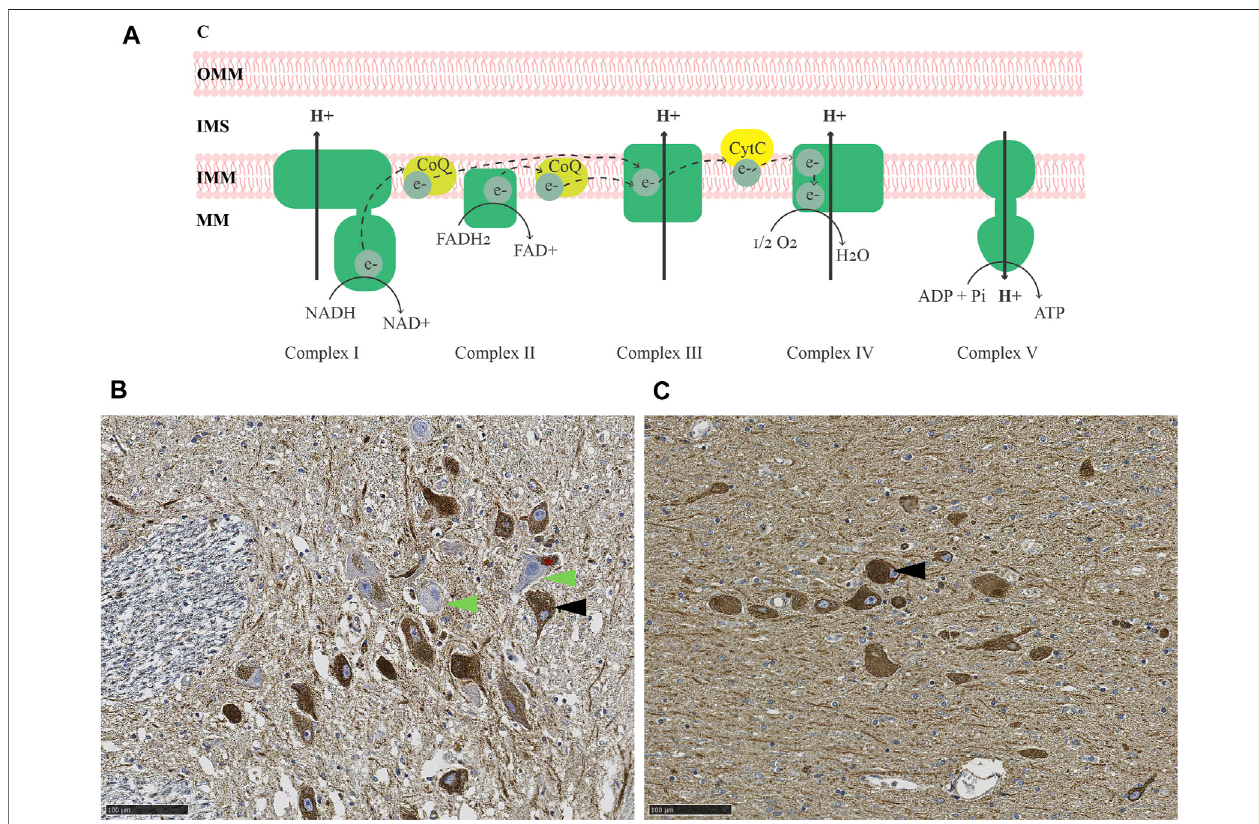
FIGURE1| MRCde fi ciencyinPD. (A) SchematicrepresentationoftheMRC.ElectronsaretransferredfromNADHandFADH 2 tocomplexIandII,respectively,and carried by ubiquinol (coenzyme Q; CoQ) to complex III. From there, electrons are further transferred to cytochrome c and transported to complex IV, which fi nally transferstheelectronsontomolecularoxygen,generatingwater.Theenergyreleasedduringtheseriesofelectrontransfersandredoxreactionsisusedtopumpprotons out of the mitochondrial matrix (MM) via complexes I, III, and IV, creating an electrochemical and pH gradient. Protons fl ow back into the mitochondrial matrix via complex V and this fl ux is coupled with the phosphorylation of ADP to generate ATP. (B – C) Immunohistochemistry for the CI subunit NDUFS4 (B) and mitochondrial massmarkerVDAC1 (C) intheSNcofanindividualwithidiopathicPD.Theasteriskin (B) indicatesneuromelaninindopaminergicneuronsoftheSNc.Arrowheadsshow examplesofCIde fi cient(green)andintact(black)neurons.Magni fi cation20X.Scalebar:100